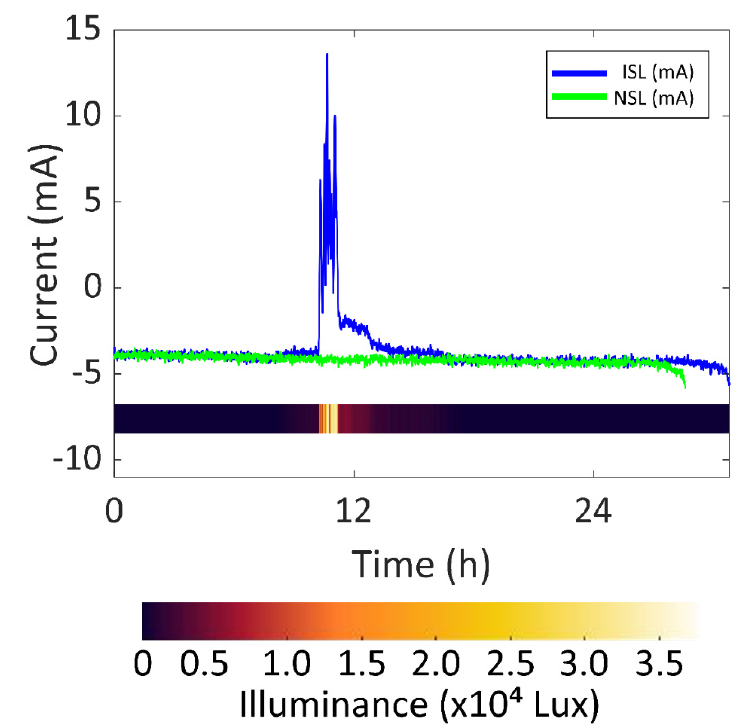
Figure 10. Battery current vs. time of ISL and NSL experiments.